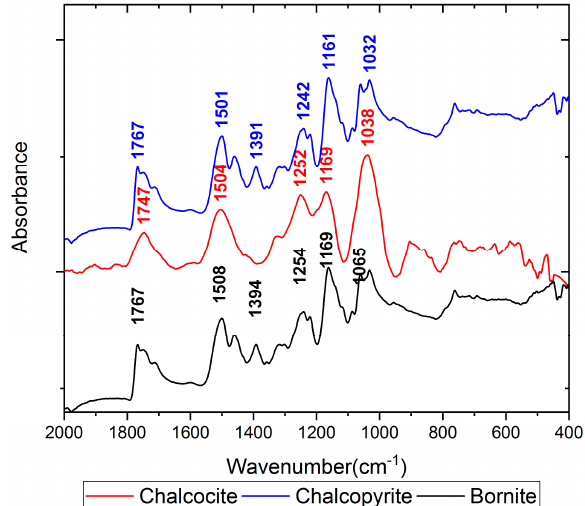
Figure 15. DRIFT spectra of thionocarbamate and xanthate collector blend (1:1) adsorption on copper sulphides at pH 8 and the total concentration of collector 3 × 10 − 5 M. Table 2. Summary of Fourier transform infrared (FTIR) bands of thionocarbamate, Cu- thionocarbamate precipitate, xanthate.